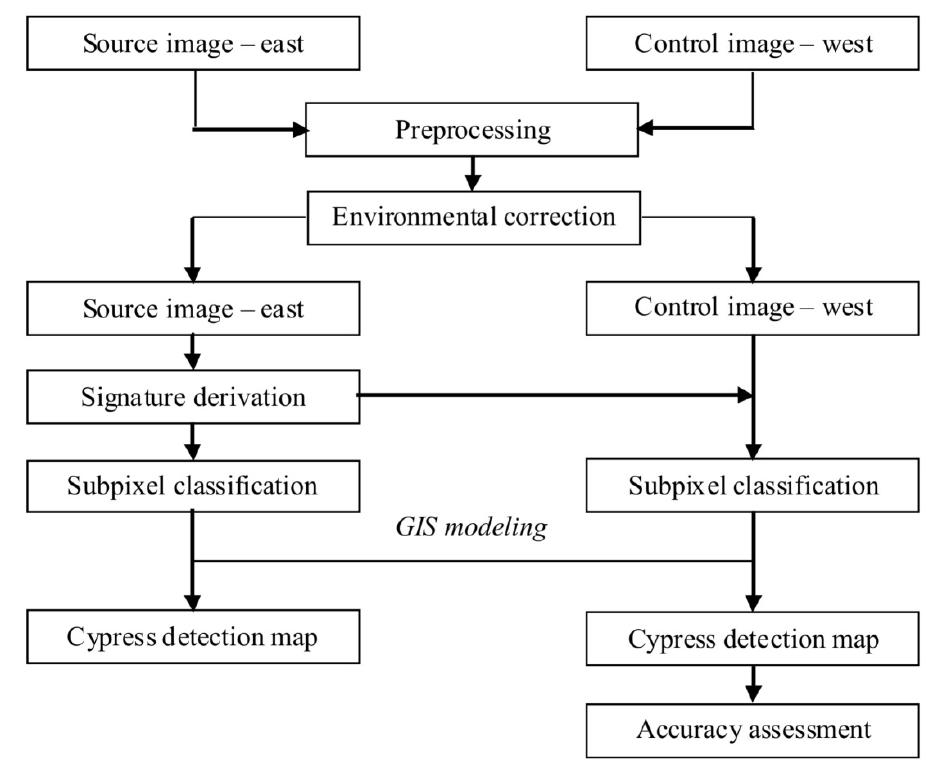
Figure 2. Flowchart of the research